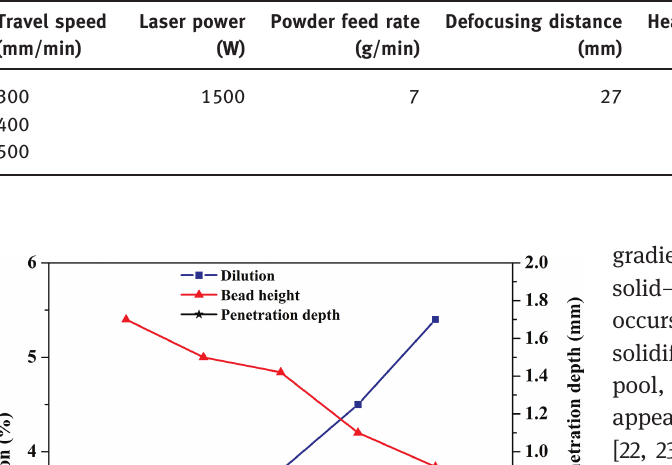
Table 5: Processes parameter and heat input for travel speed.